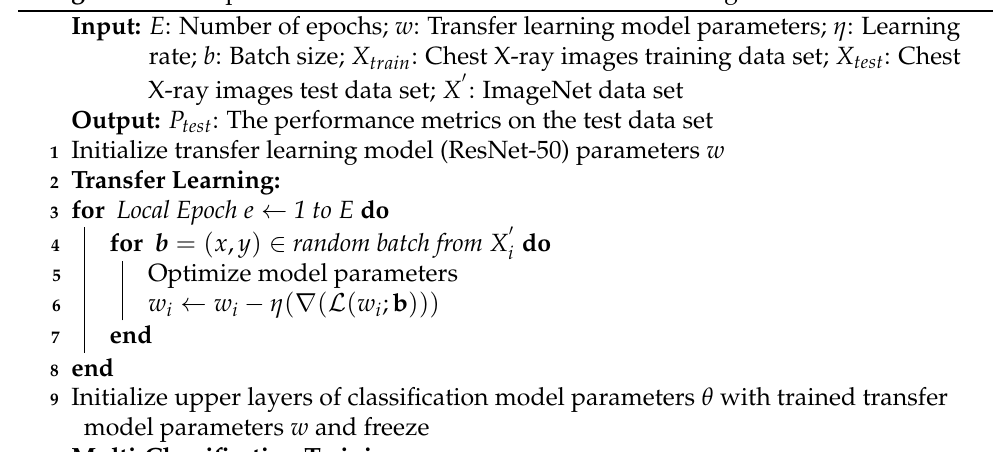
Algorithm 1 Proposed R2DCNNMC model for COVID-19